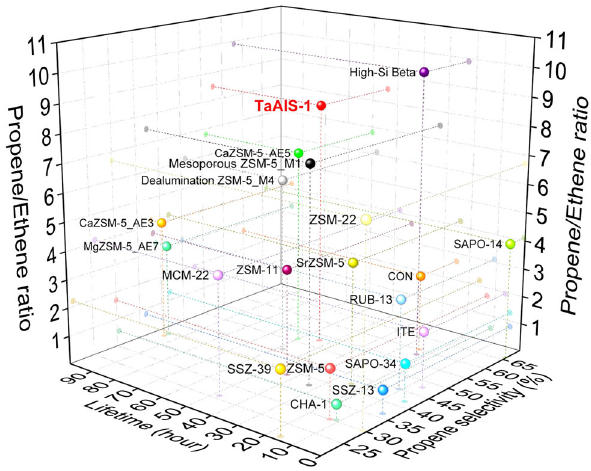
Fig. 1 Comparison of propene selectivity-propene/ethene ratio-catalytic stability of selected MTO catalysts. 3D plot of P/E ratio versus lifetime and propene selectivity, showing the balance of catalytic performance of selected zeolites for conversion of pure methanol to ole fi ns at methanol conversion ≥ 95%. For clarity, only representative zeolites are shown in the plot. Full data are listed in Supplementary Table